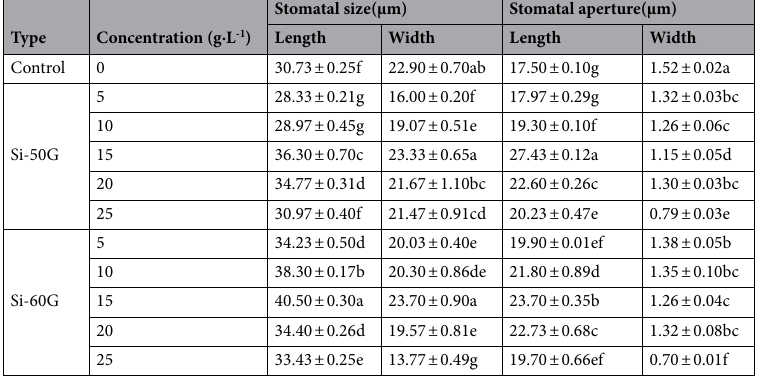
Table 5. Effects of Si (5, 10, 15, 20 or 25 g·L −1 ) on stomatal size and aperture. The values represent the mean ± SE (n = 4). Values with the same letters in the columns are not significantly different at P <